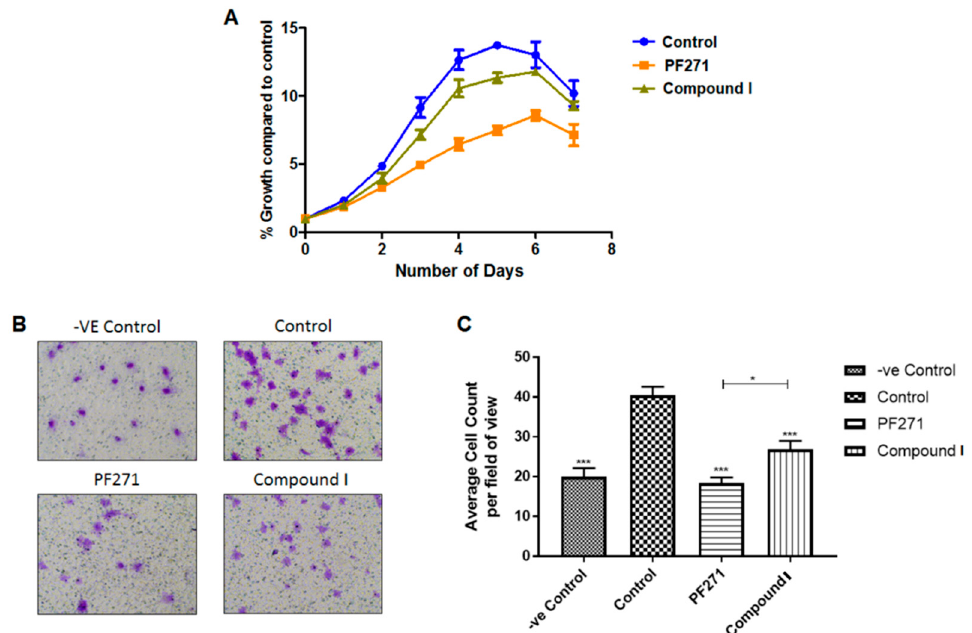
Figure 7. ( A ) Relative 7-day proliferation of MDA-MB-231 cells in vitro in the presence of 1 µ M compound I or PF271 compared to vehicle-only control. ( B ) Representative images of Boyden chamber migration assays incubated with compound I or PF271, post 18 h serum-stimulated migration. ( C ) Quantified results of anti-migratory e ff ects of compound I and PF271 from 18 h Boyden chamber migration assay. Negative (-ve) control represents non-serum stimulated cell migration. Data represent the average number of cells / membrane across duplicate wells and 3 replicates. Error bars show SEM: * p < 0.05; *** p < 0.001.